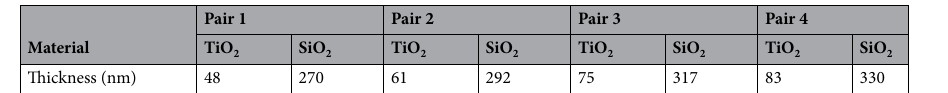
Table 1. The layer thicknesses of the addressed chirped magnetophotonic